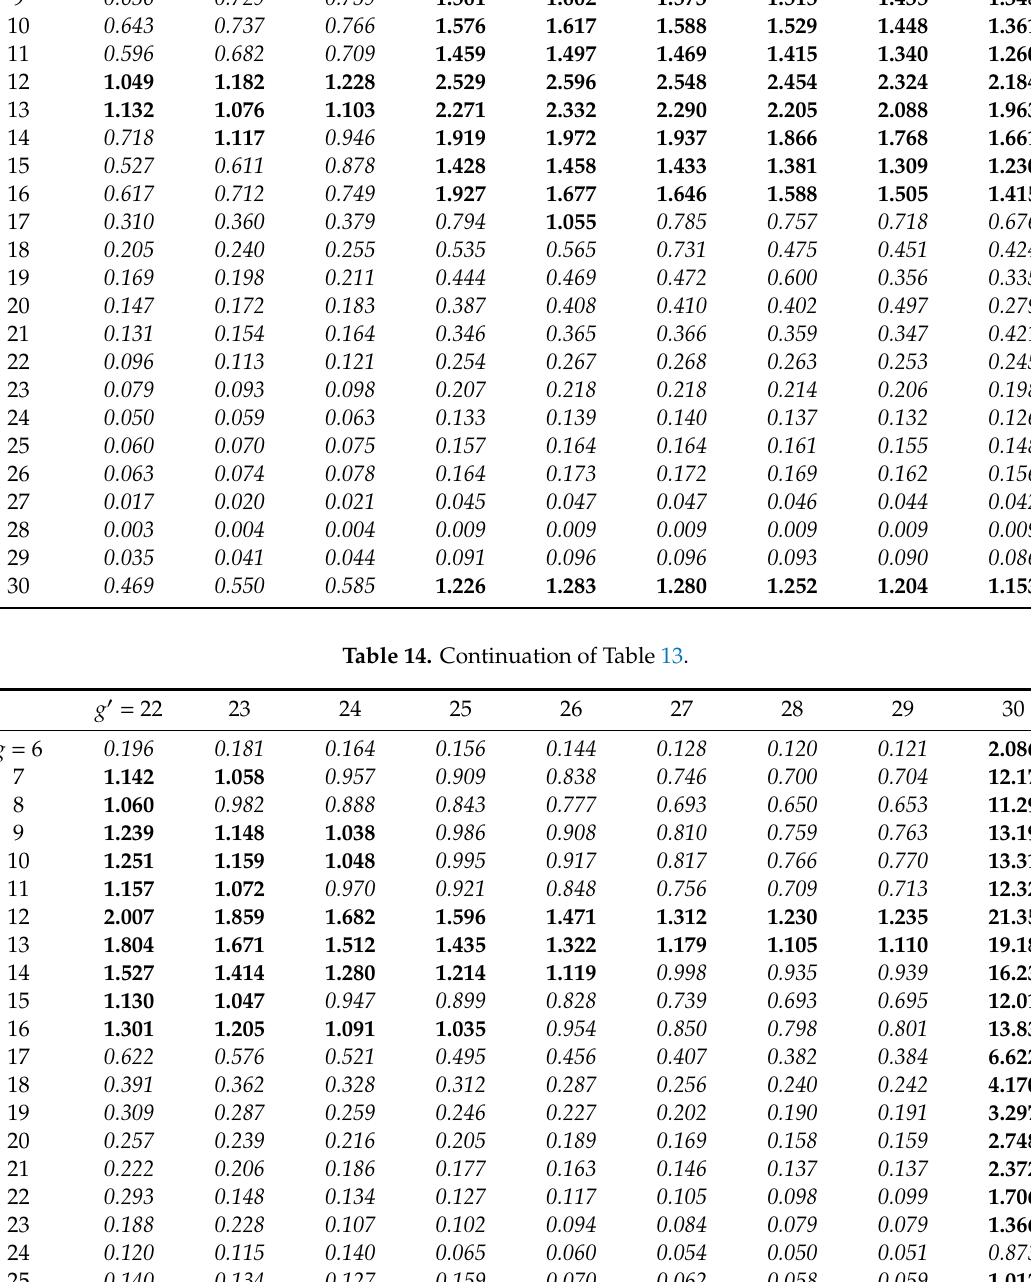
Table 13. Components of S ( 2 )